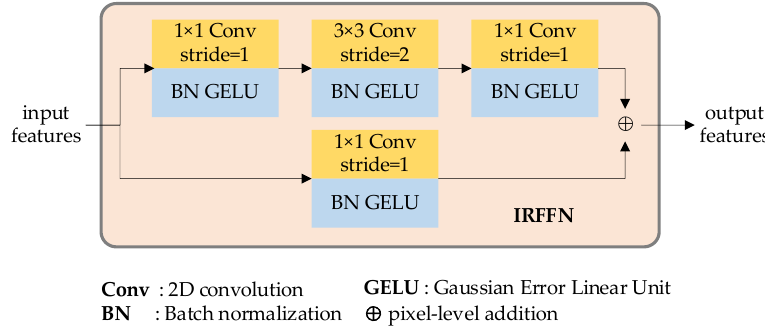
Figure 6. IRFFN block diagram.